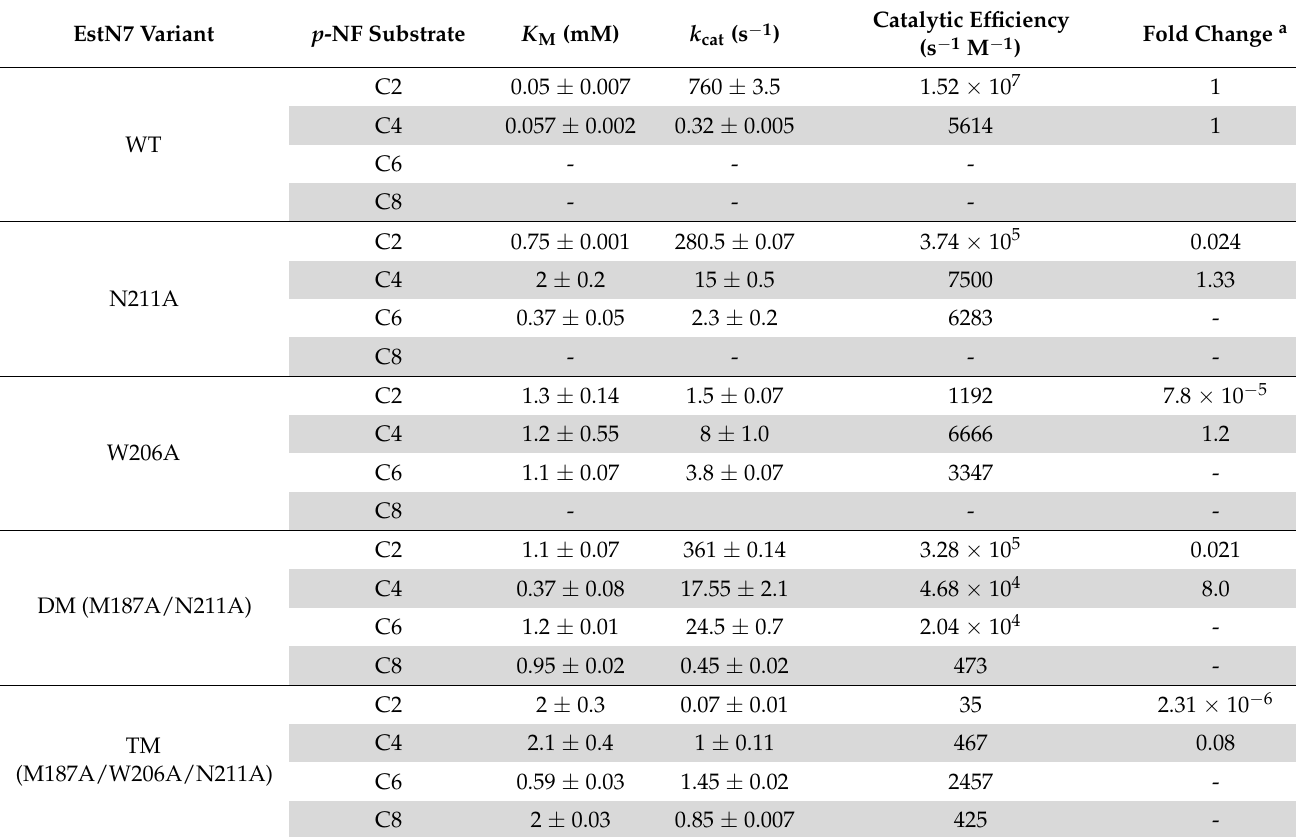
Table 1. Substrate specificity of wild-type EstN7and its engineered